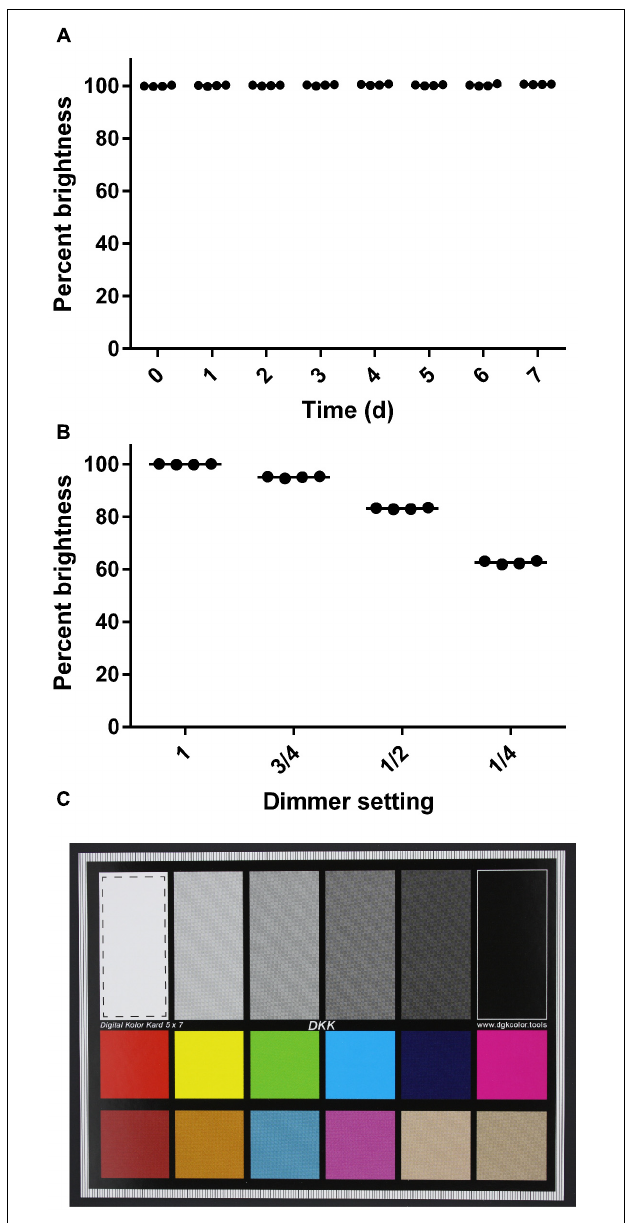
FIGURE 3 | Consistency of images captured with the imaging box. (A) Percent brightness of an image standard over a 7-day time course. The dimmer was removed from the apparatus for this series. Dots represent individual replicates ( n = 4), and the bars represent means. The first time point is set to 100% brightness. (B) Percent brightness of an image standard captured at different dimmer settings. Dots represent individual replicates ( n = 4), and the bars represent means. The brightness value obtained at the maximum dimmer setting is scaled to 100%. (C) Image standard used. The dashed line box in the white rectangle shows the area that was analyzed for mean brightness values in ImageJ.